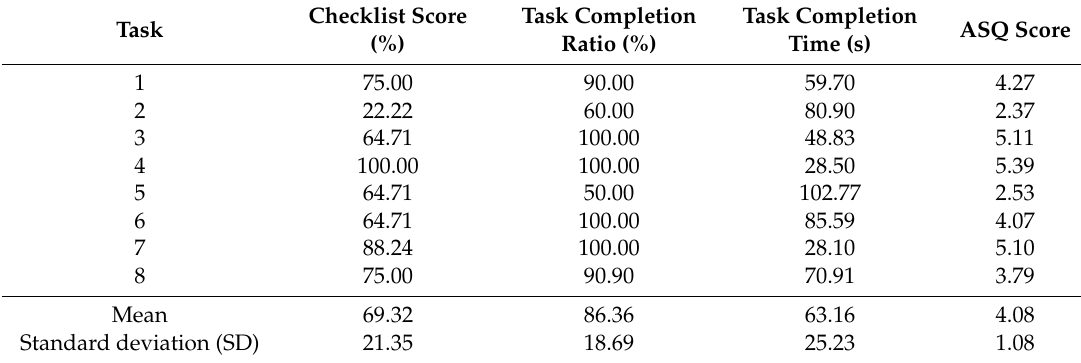
Table 5. Usability measures of each method.